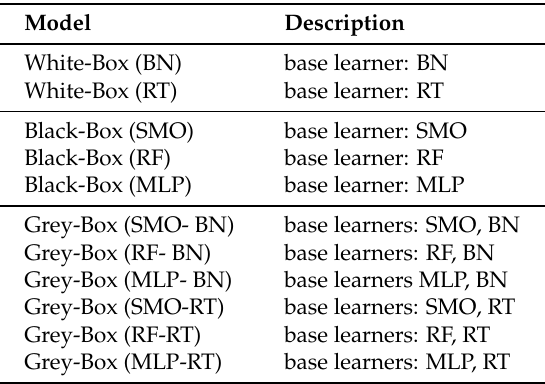
Table 2. White-, Black-, and Grey-Box models summary.